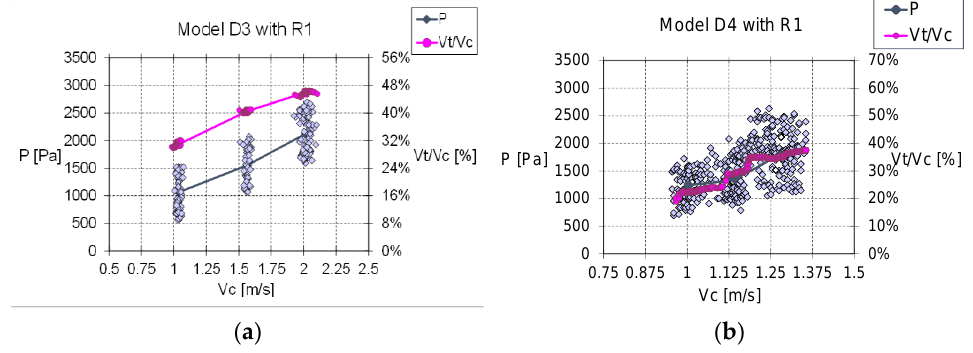
Figure 19. Characteristics 𝑃 and 𝑉 𝑡 /𝑉 𝑐 with resistance R1, for models D3 ( a ) and D4 ( b ).